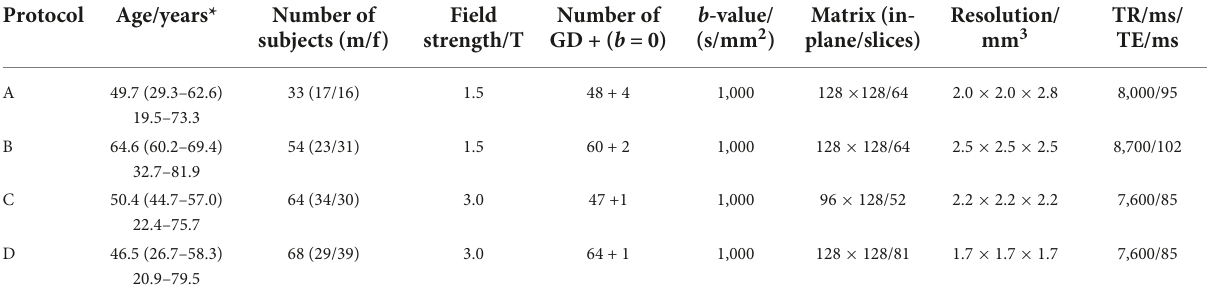
TABLE 1 Study population and imaging data.